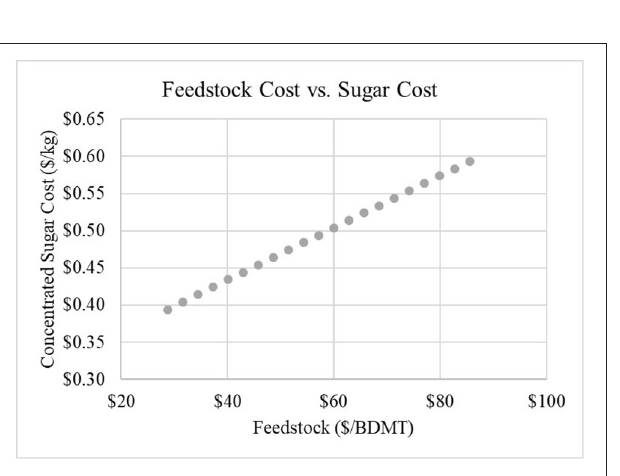
FIGURE 4 | Impact of delivered feedstock cost on concentrated sugar cost.